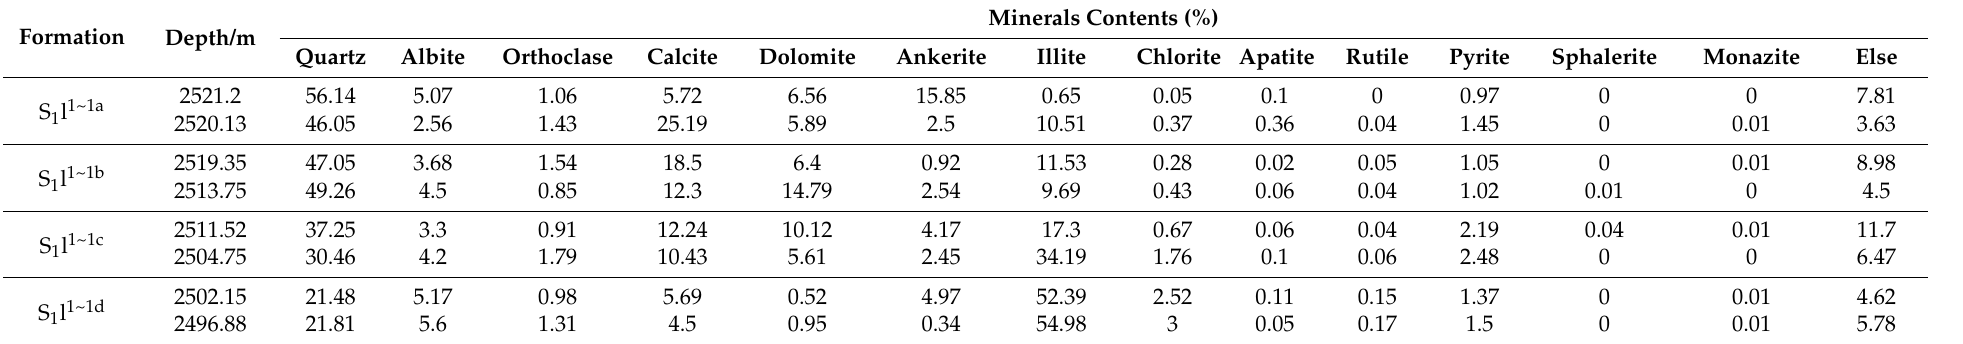
Table 2. Contents of minerals of S1l1 member shale from the QEMSCAN